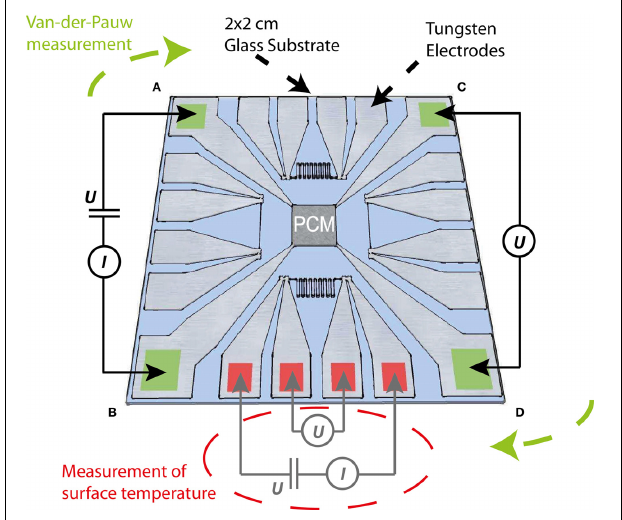
FIGURE 2 | Structure of the phase change thin film samples. The 3.5 × 3.5mm 2 phase change area in the middle of the substrate is contacted by four tungsten electrodes (marked in green), which were patterned at the edges of the 2 × 2cm 2 glass substrate. Besides the Van-der-Pauw structure 10 µ m wide tungsten lines are integrated at each side of the substrate (two line and two zig-zag structures). The different tungsten line structures (each electrically contactable via four contact pads) serve as temperature sensors of the surface temperature of the substrate in close proximity to the phase change